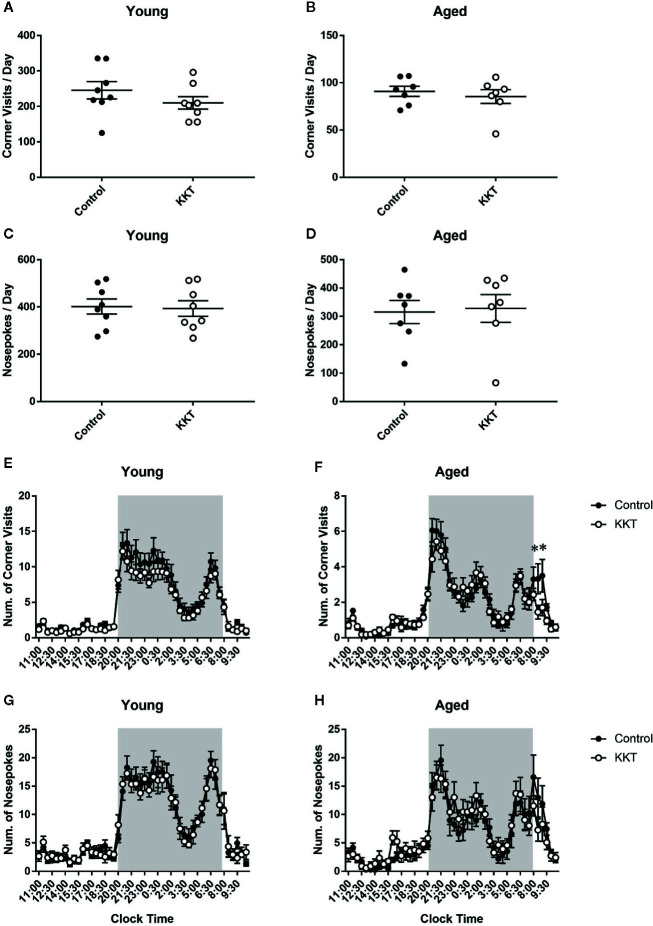
Effects of KKT on basal activities. (A–D) Scatterplot depicting the number of corner visits (young: (A); aged (B) and NPs (young: (C); aged (D) per day are presented as the mean ± SEM. Statistical significance was analyzed using unpaired t-tests. (E–H) The diurnal variation of corner visits (young: (E); aged: (F) and NPs (young: (G); aged (H) logged every 30 mins. Shaded area indicates the dark period (20:00–8:00). Data are expressed as mean ± SEM. n = 8 (young) and 7 (aged), *: P < 0.05, Bonferroni’s multiple comparison.